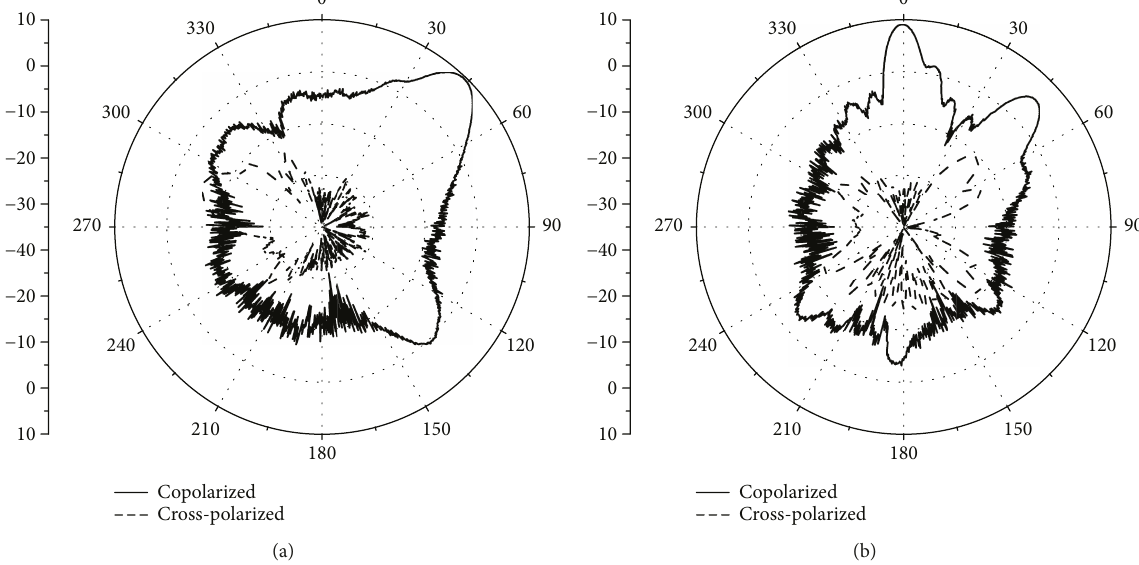
Figure 14: Measured radiation patterns of the antenna arrays: (a) Con fi guration 1; (b) Con fi guration